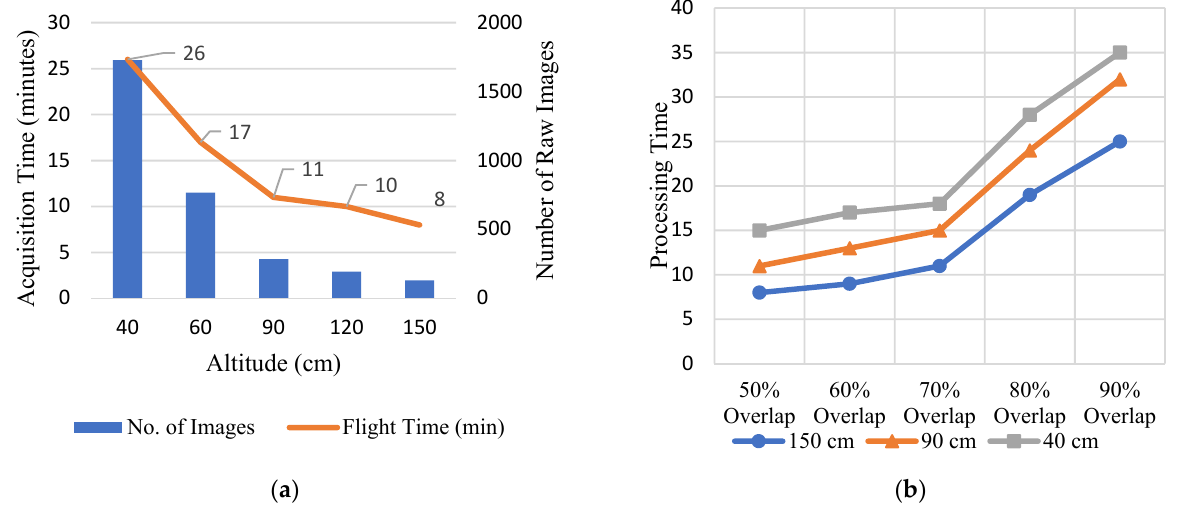
Figure 9. ( a ) Acquisition time for different altitude at 70% image overlap; ( b ) Image processing time in minutes for different overlap percentage at 40 cm, 90 cm, 150 cm, respectively.